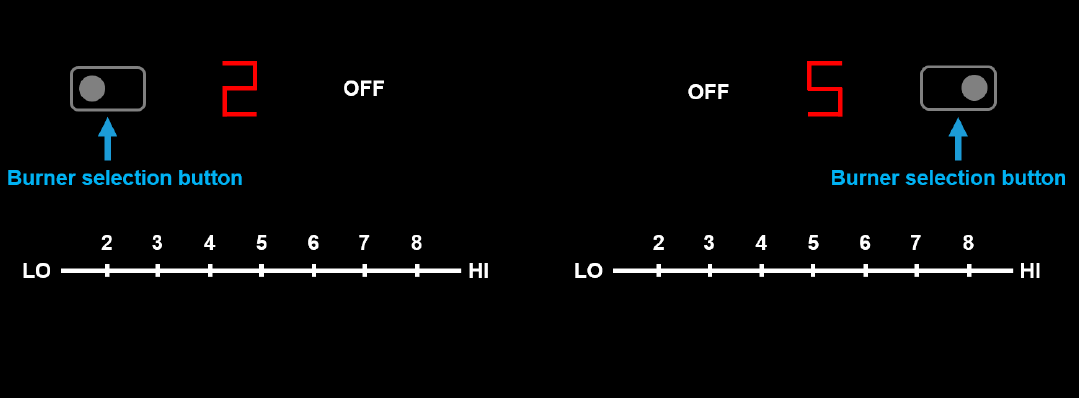
Figure 2. Touchscreen panel mockup.